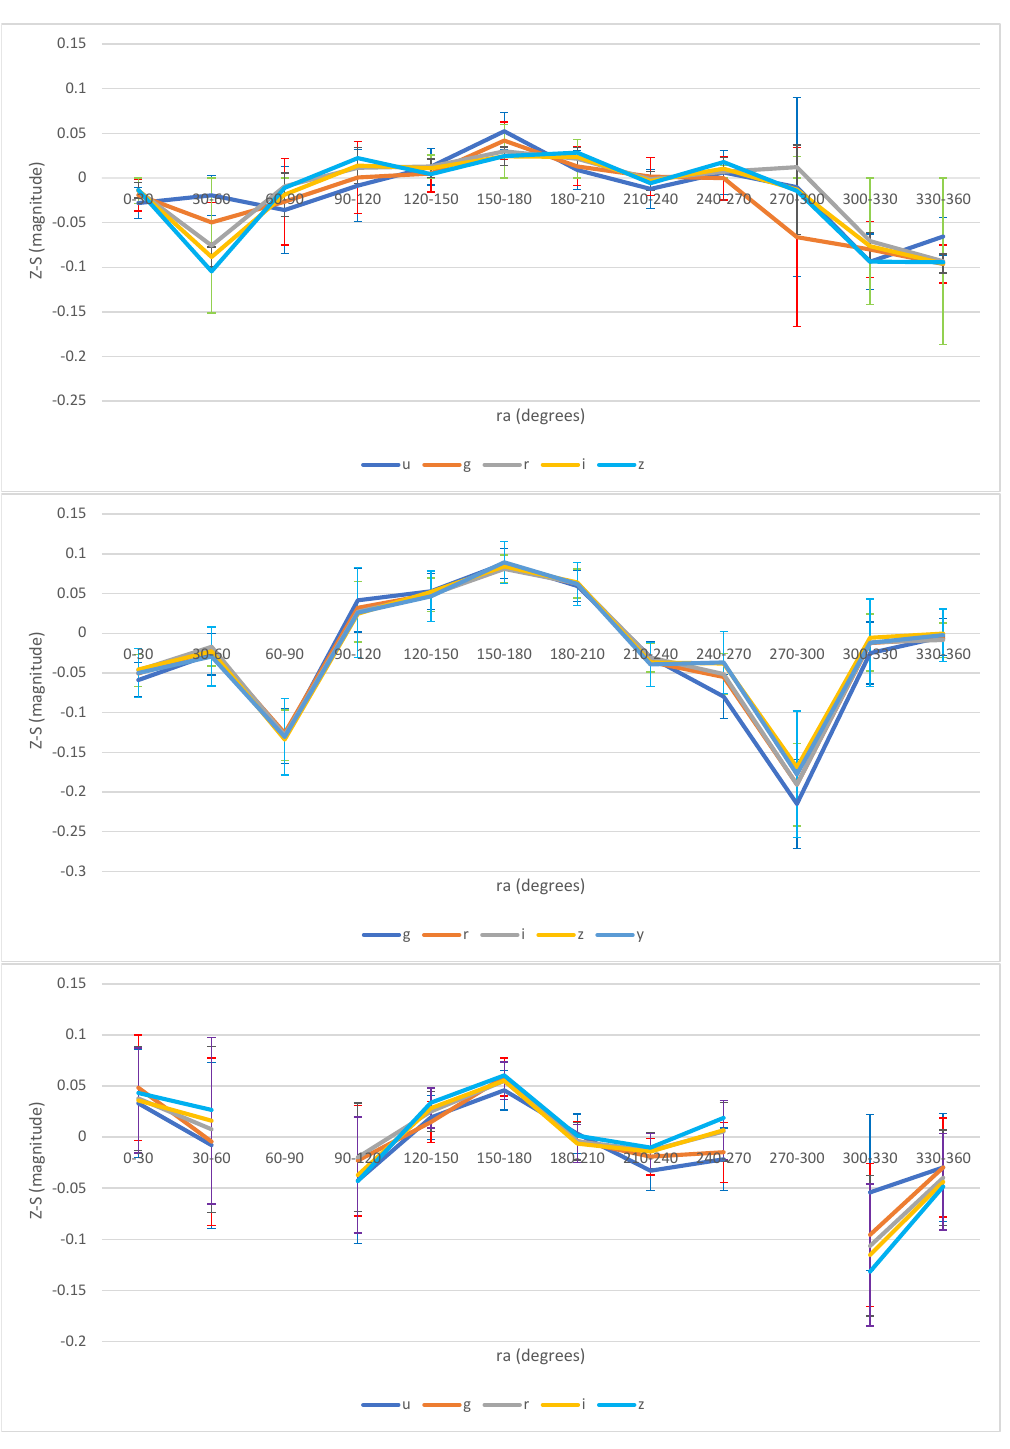
Figure 5. Asymmetry between the exponential magnitude of clockwise (Z) and counterclockwise (S) galaxies in different RA ranges using SDSS automatically annotated galaxies (top), SDSS manually annotated galaxies (middle), and Pan-STARRS galaxies (Shamir 2017b). The error bars show the standard error of the difference between the mean magnitude of clockwise and counterclockwise galaxies in each